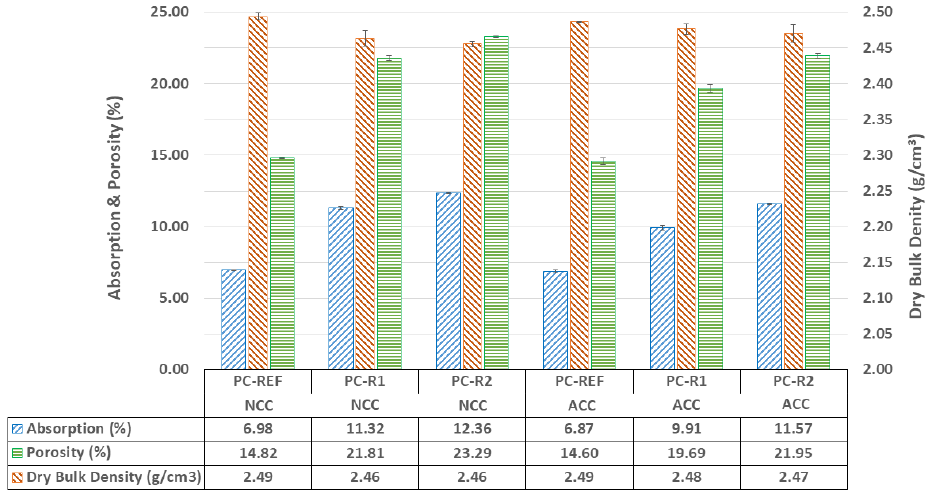
Figure 4. Dry bulk density, water-accessible porosity and absorption for the different mixtures at a curing age of 28 d for the different curing environment regimes.